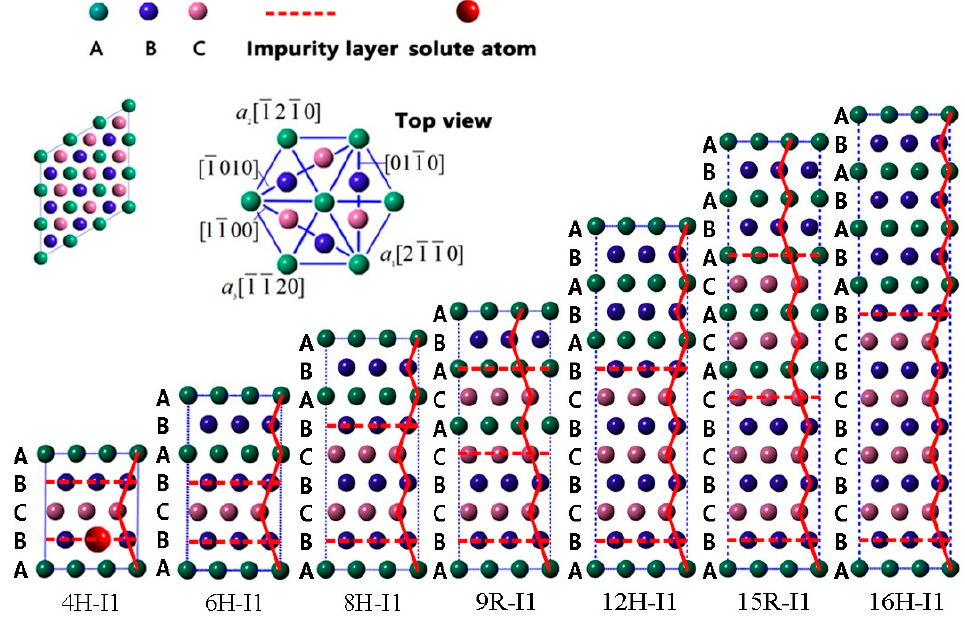
Figure 1. The I1-constitute LPSO structures for 4H, 6H, 8H, 9R, 12H, 15R, and 16H phases. The variables are defined as energy